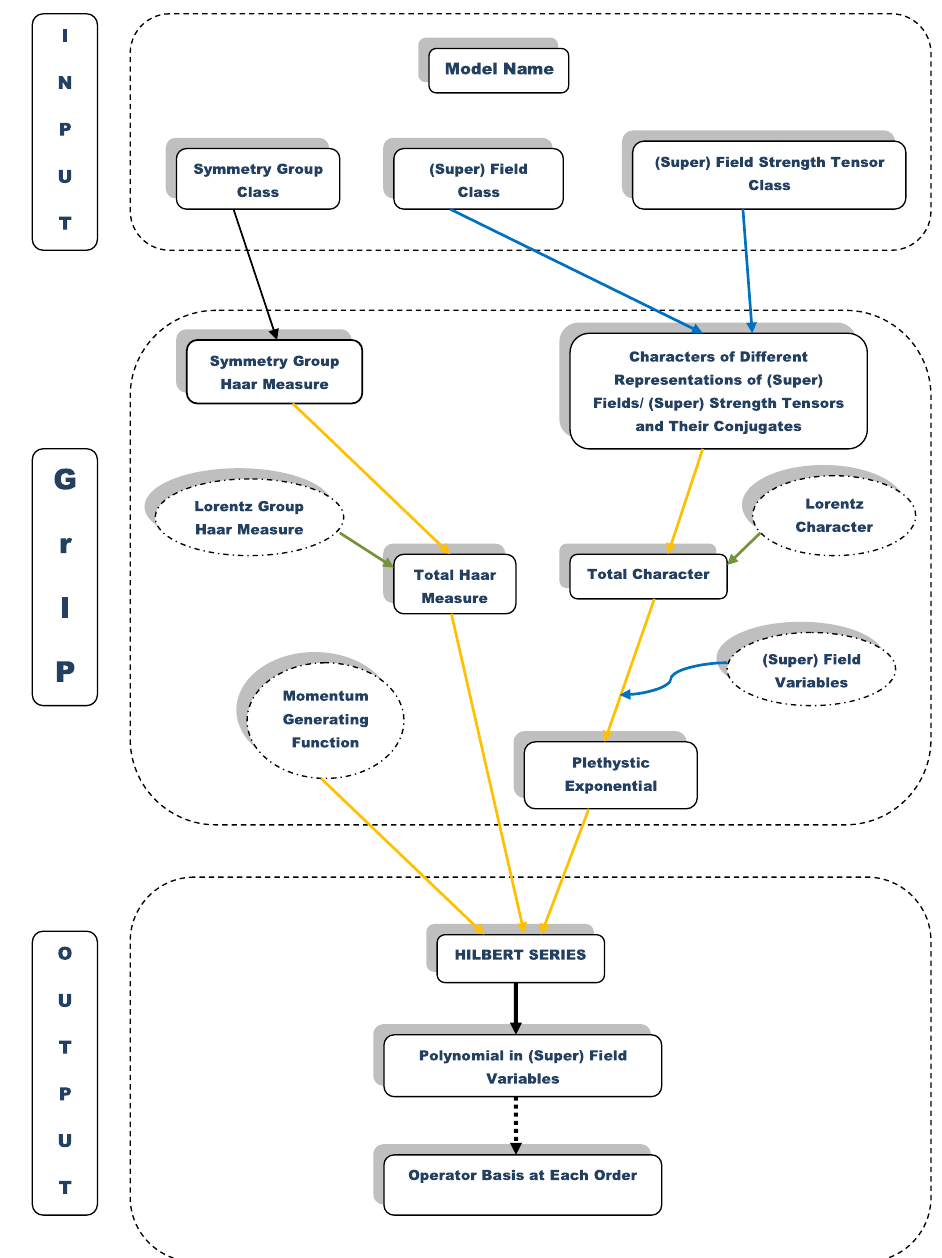
Fig. 6 A flow chart depicting the major components of GrIP and the algorithm on which it is